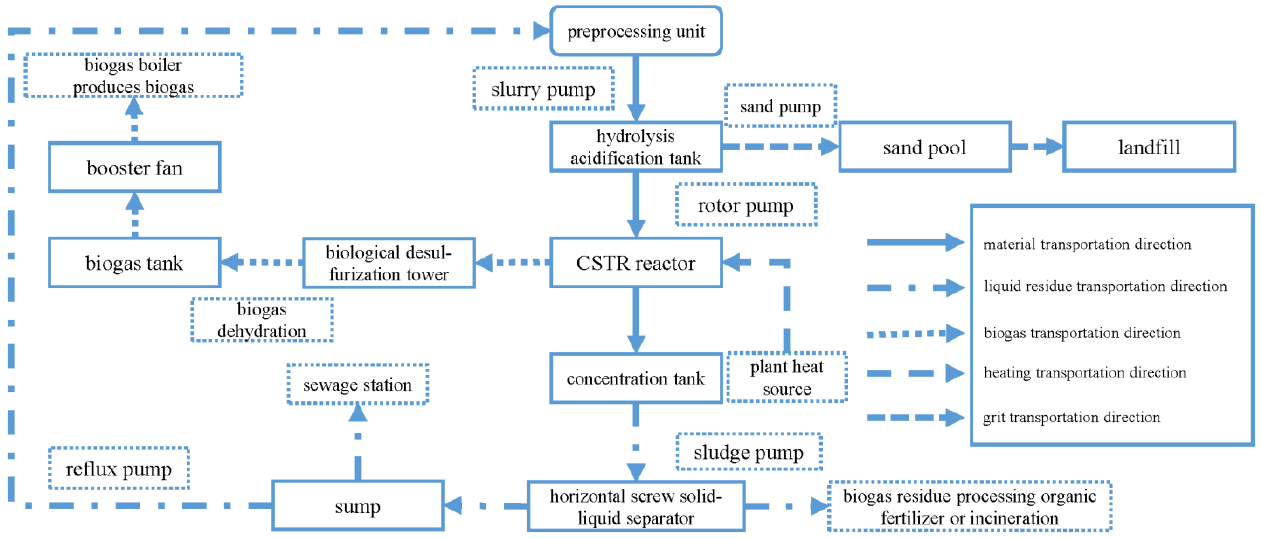
Figure 1. Two-phase anaerobic digestion process flow chart.